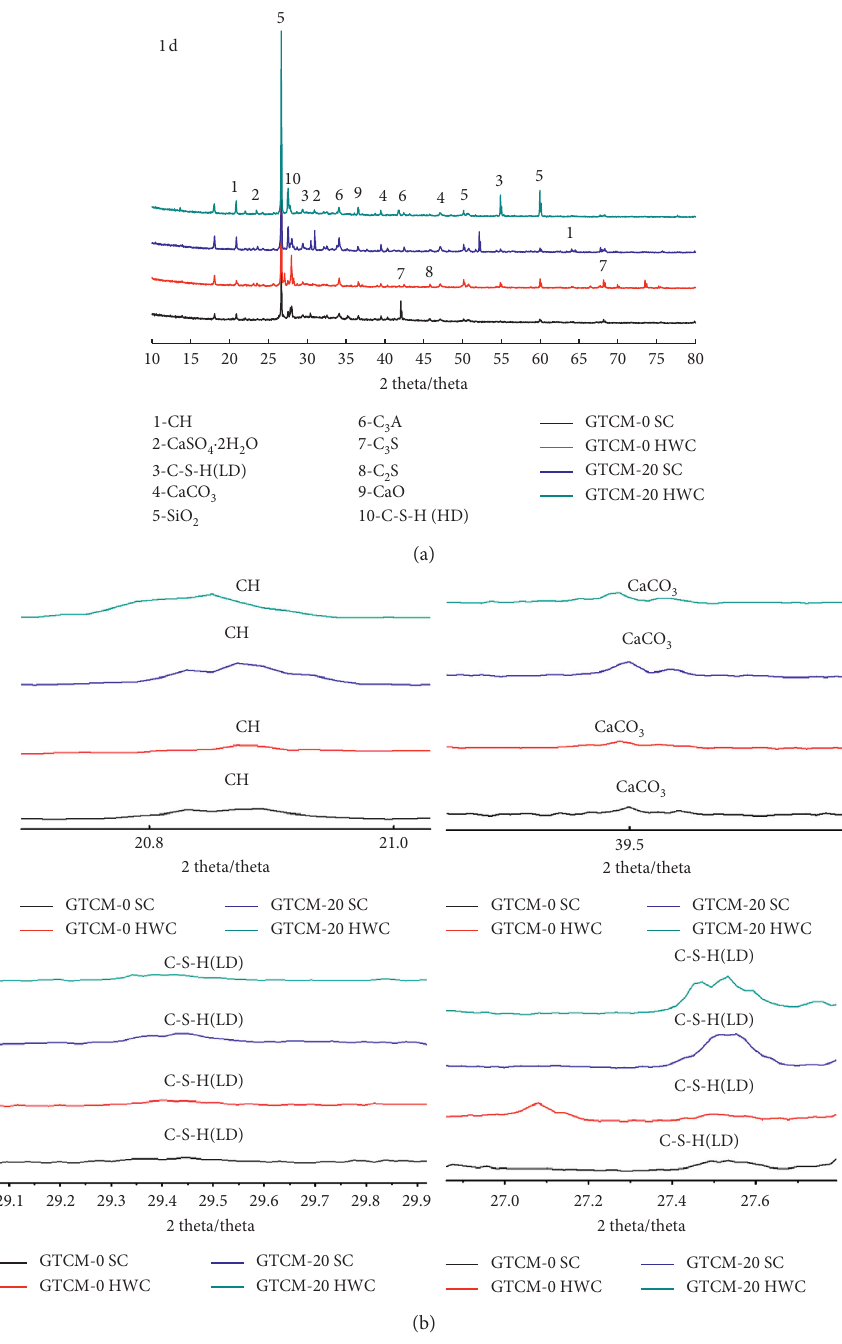
Figure 8: Hydration product analysis of GTCM-0 and GTCM-20 under SC and HWC methods for 1